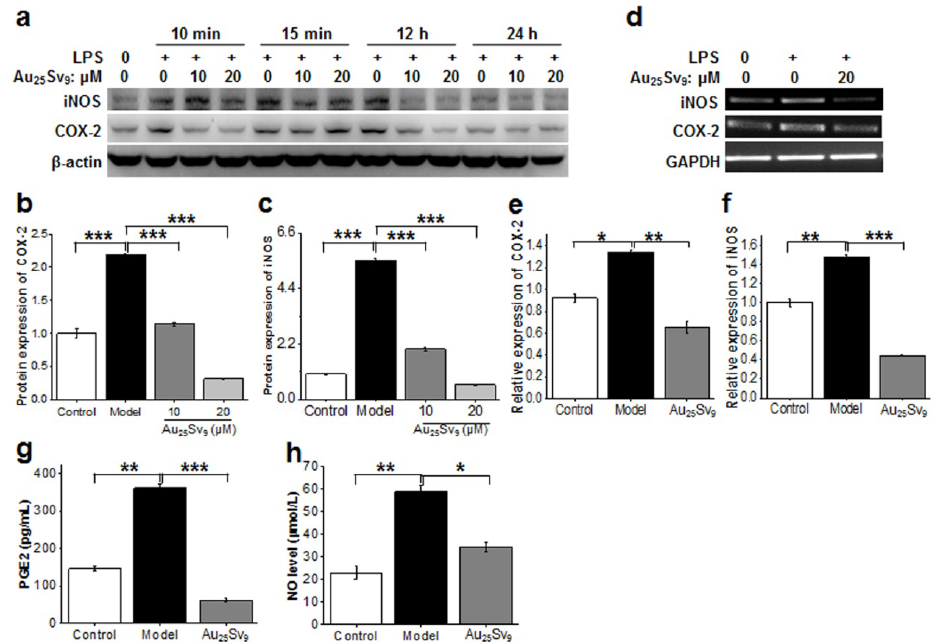
Figure 3. The e ff ect of Au 25 Sv 9 on COX-2 (Cyclooxygenase-2) and iNOS (inducible nitric oxide synthase) expression and PGE2 (prostaglandin E2) and NO (nitric oxide) production in LPS (lipopolysaccharide)-stimulated HBZY-1 cells. ( a ) Western blotting detection of the expression of COX-2 and iNOS at di ff erent time points. β -actin was used as the loading control. ( b ) The densitometry analysis of COX-2 immunoreactive bands at 12 h; β -actin was used to normalize the data. Data was expressed as the mean ± standard deviation (n = 3). ( c ) The densitometry analysis of iNOS immunoreactive bands at 12 h. β -actin was used to normalize the data. Data are presented as the mean ± standard deviation (n = 3). ( d – f ) The e ff ect of Au 25 Sv 9 on the LPS-induced transcription of COX-2 and iNOS in HBZY-1 cells after 12 h incubation. GAPDH was used as the internal control and was used to normalize the data. ( d ) Representative images of RT-PCR (Reverse transcription PCR) and ( e , f ) the quantitative analysis of RT-qPCR (real-time quantitative PCR) were shown. Each data was expressed as the mean ± standard deviation (n = 3). ( g , h ) The e ff ect of Au 25 Sv 9 on the LPS-induced production of PGE2 and NO in the supernatant of HBZY-1 cells after 24 h incubation. Data are presented as the mean ± standard deviation (n = 3). * P < 0.05, ** P < 0.01, *** P <